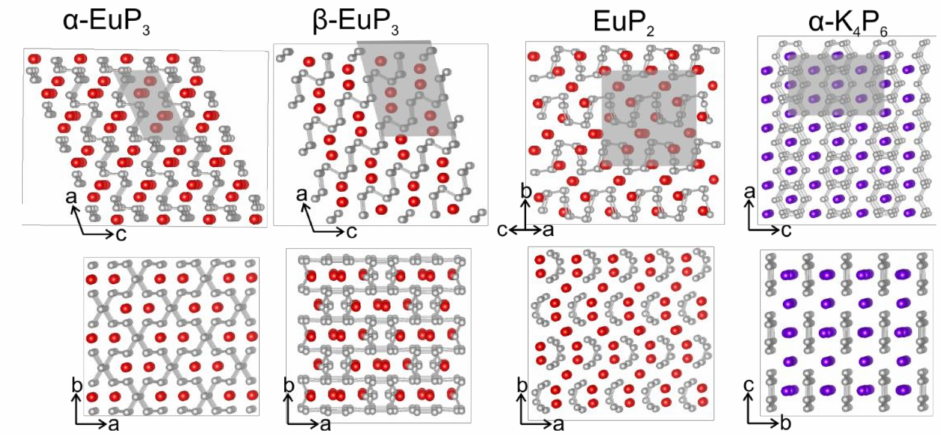
Figure 3. The crystal structures of two EuP 3 phases, EuP 2 , and α -K 4 P 6 are shown along two different directions. The unit cells are highlighted with gray boxes. P: gray, Eu: red; K: